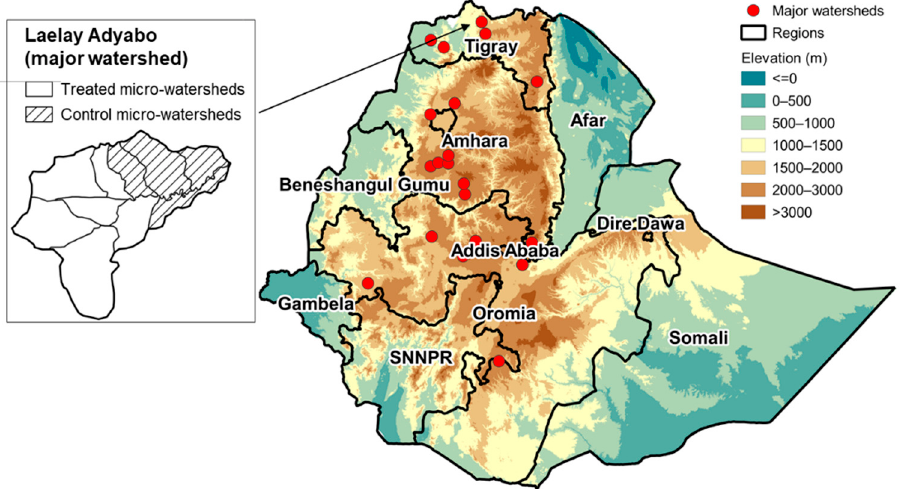
Figure 1. Overview map of the location of the study areas (i.e., major watersheds) and